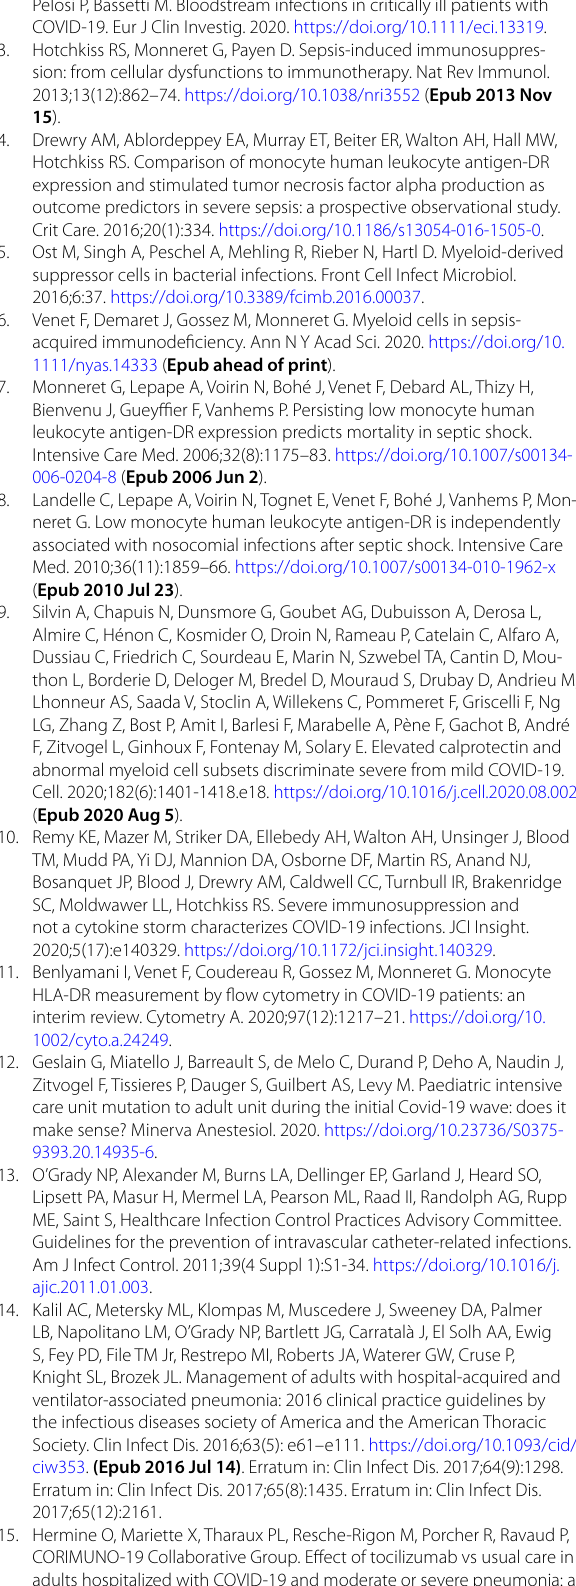
Additional file 1: Figure S1. Monocyte HLA‑DR variation in patients with or without secondary infection. Table S1. Circulating cells phenotyping antibodies clones. Table S2. Site of secondary infection and associated